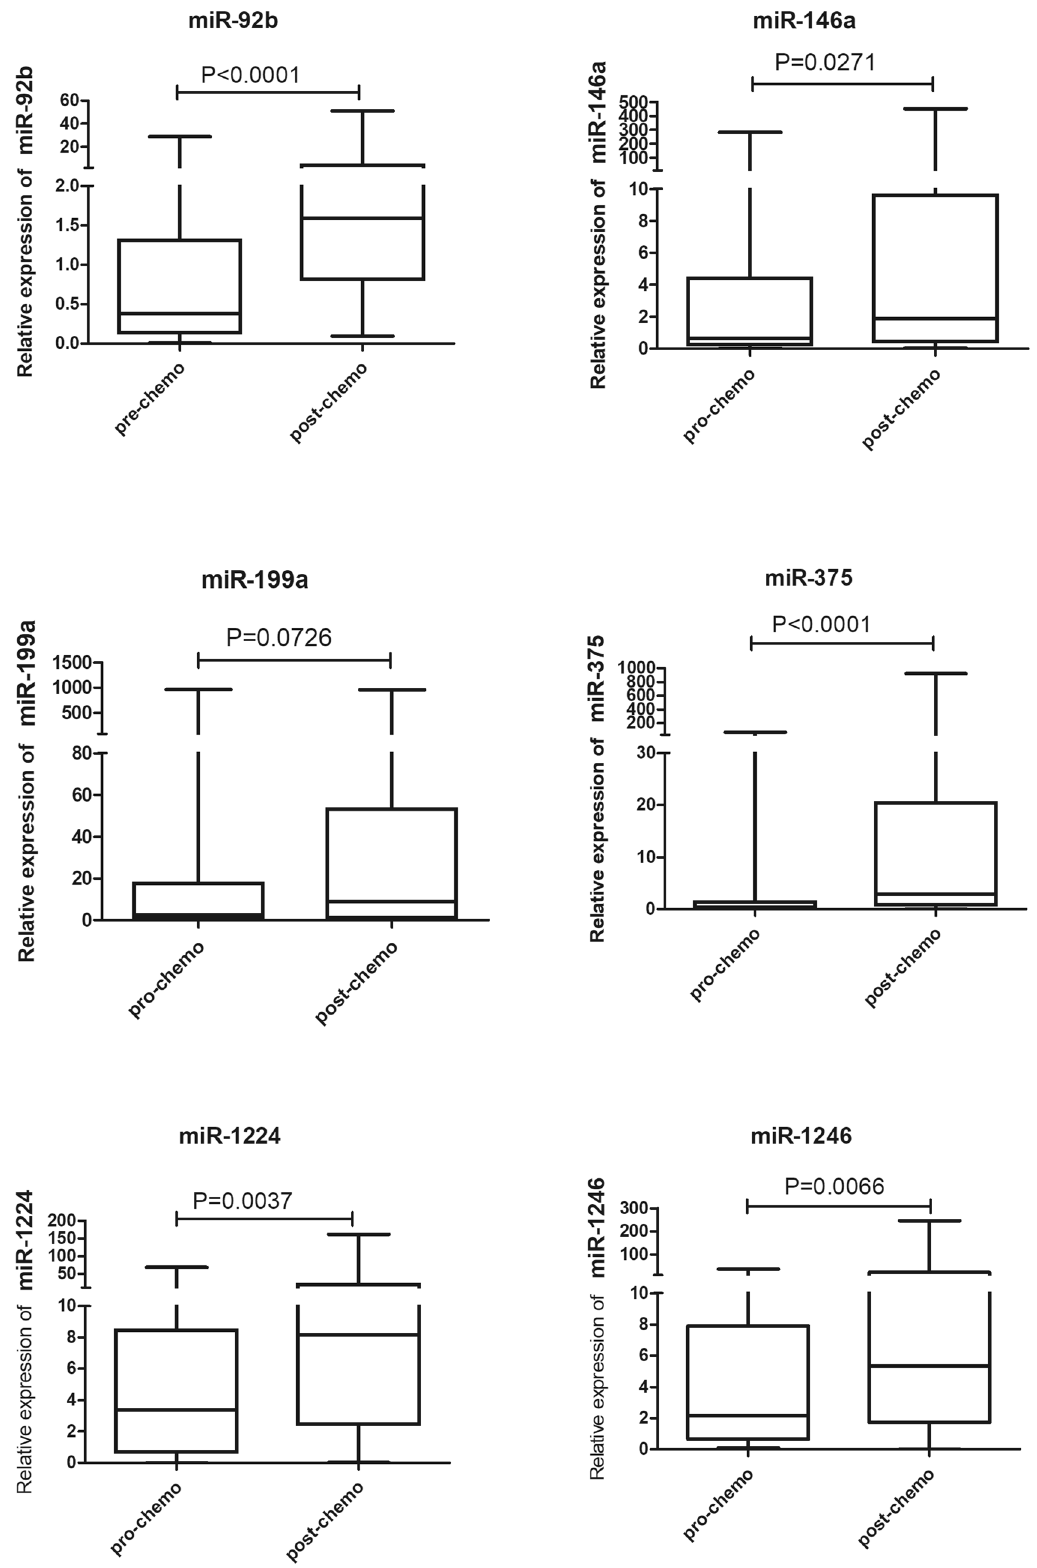
Figure 1. Plasma levels of 6 miRNAs in SCLC patient plasma. The box plots show the plasma levels of miR-92b, miR-146a, miR-199a, miR-375, miR-1224 and miR-1246 at pre- and post-chemoresistance